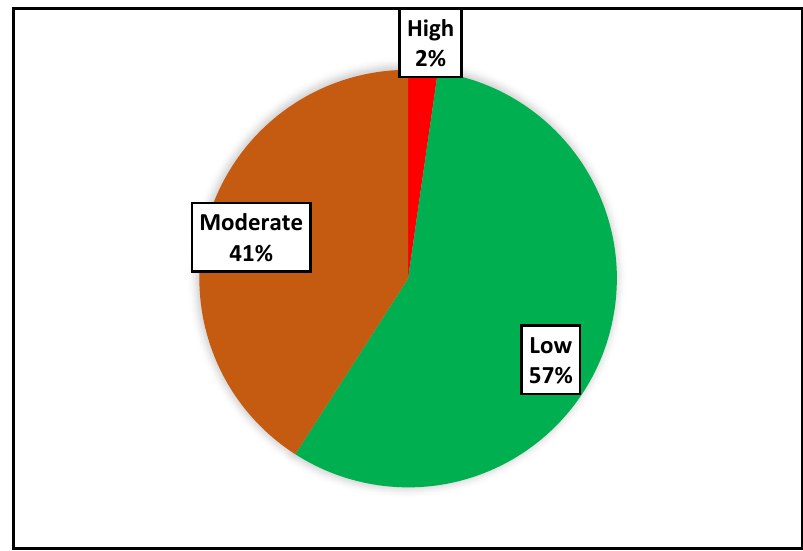
Figure 4. The risk level of developing a CVD among the community cohort study.